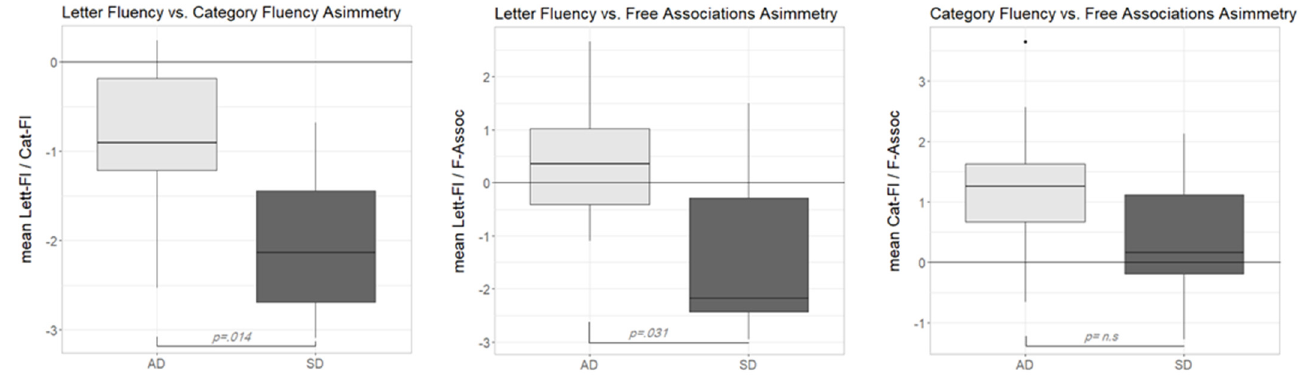
Figure 2. Boxplots showing the distribution of the asymmetry scores according to the participant groups. AD—participants with Alzheimer’s disease, NC—normal controls, SD—participants with semantic dementia.